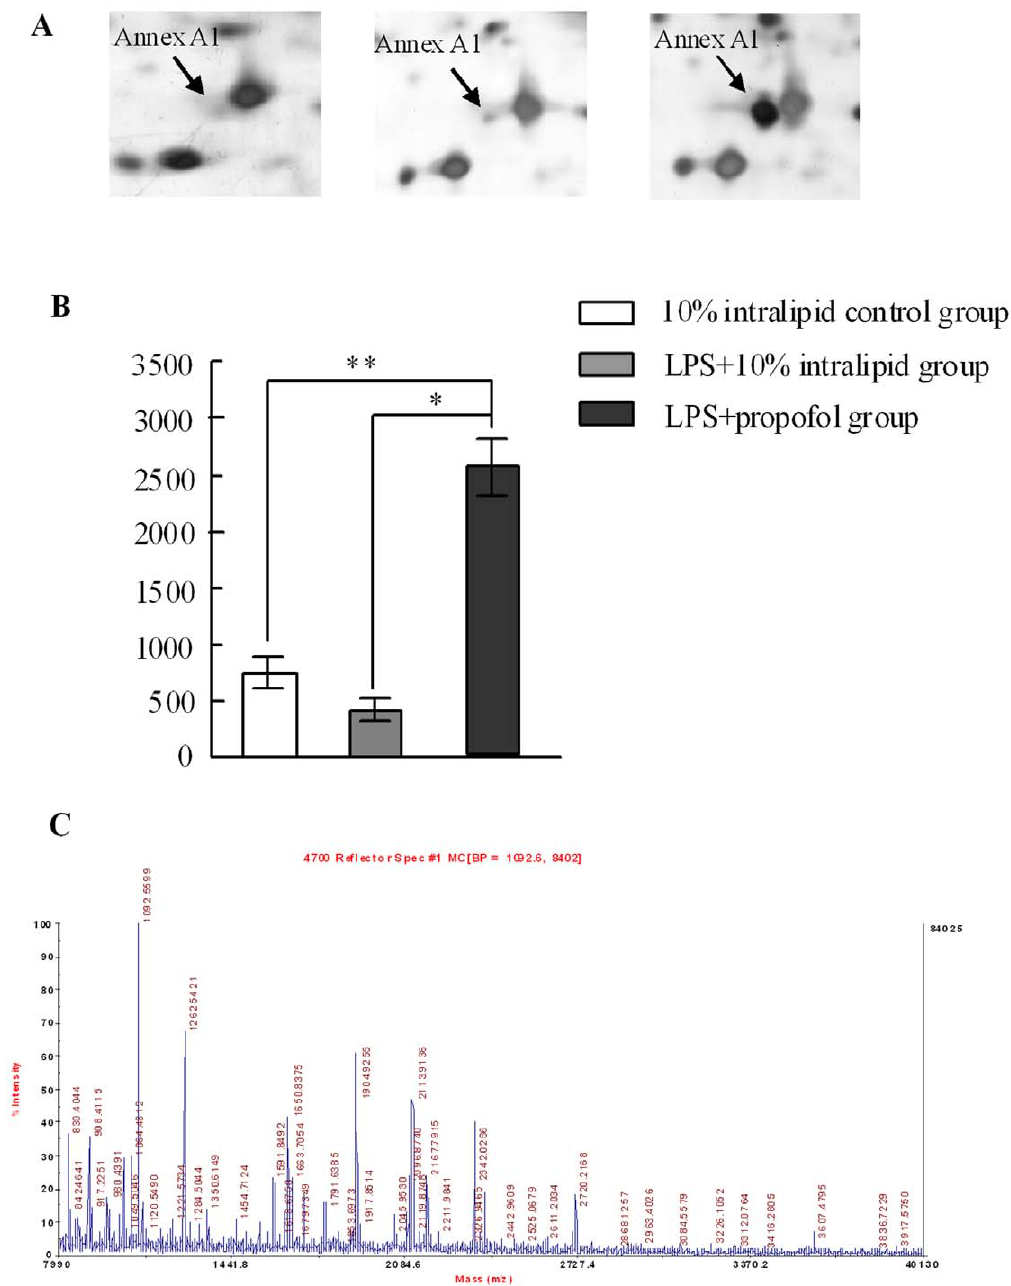
Figure 2. Identification of Annexin A1 up-regulation in LPS + propofol group. A. Gels in control(1), LPS(2), and LPS + propofol(3) group has been enlarged to show the high expression of Annex A1 in three groups. B. The densitometric analysis of each protein was calculated from 9 different gels using PDQuest software. Each bar represents the mean 6 SD of intensity, the expression of Annex A1 in LPS + prpofol group increased dramatically compared with LPS + Intralipid group(*p , 0.001) and control Group(**p , 0.001). C. MSMS of in-gel trypsin digests of the protein and analysis of the depicted peptide spectrum resulted in the identification of Annex A1.